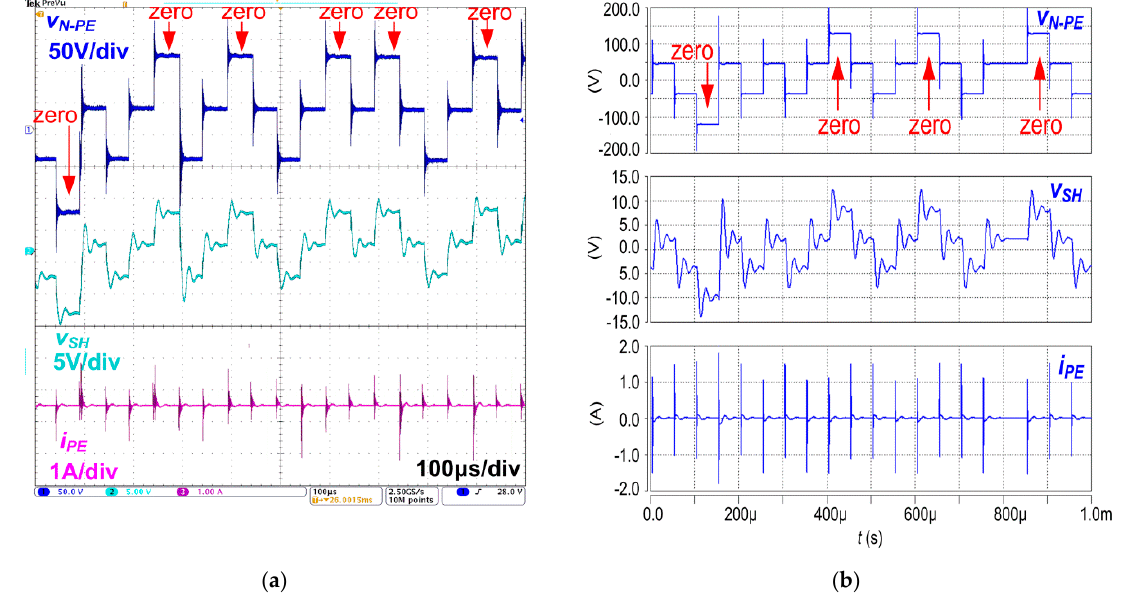
Figure 18. Waveforms of CM voltage u N-PE , shaft voltage u SH, and leakage ground current i PE in a drive system fed by a hard-switched inverter: ( a ) measurement; ( b ) simulation.